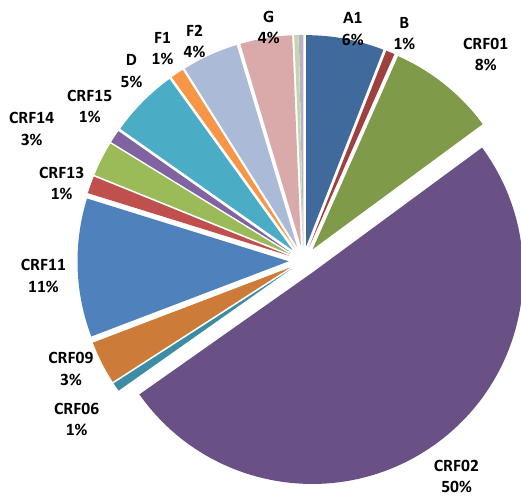
Figure 2. Distribution of virus subtypes in 302 patients with virological failure in Central Africa.